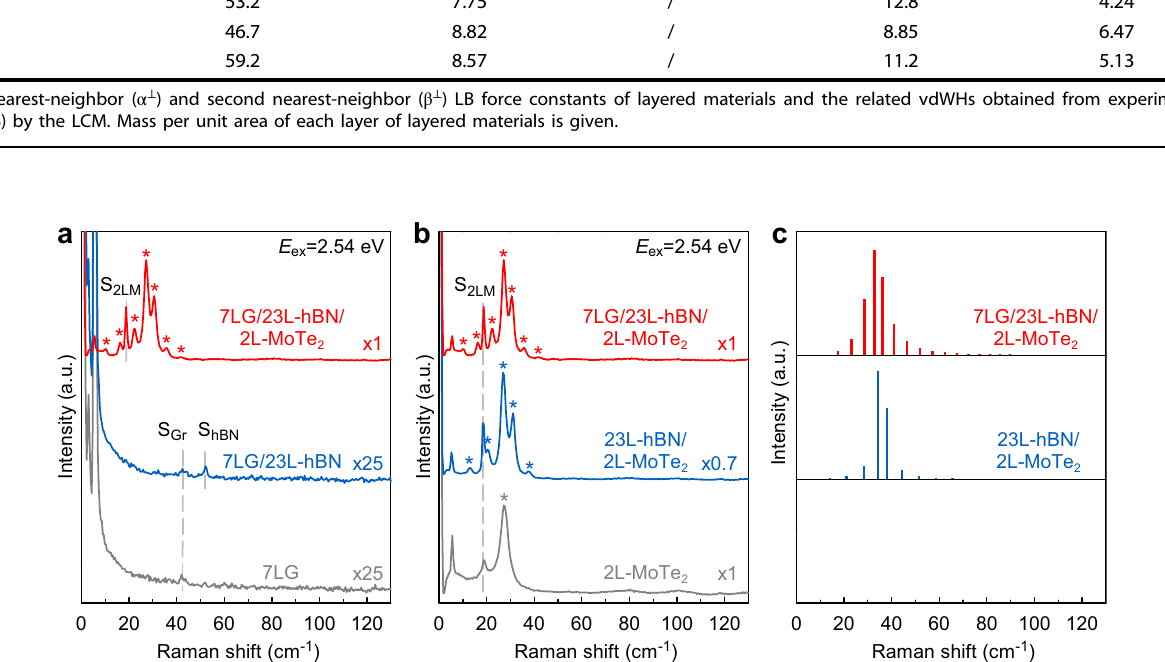
Fig. 4 Evolution of interlayer modes from individual constituents to Gr/hBN/MoTe 2 vdWH. a LF Raman spectra of 7LG, 7LG/23L-hBN, and 7LG/23L-hBN/2L-MoTe 2 . b Raman spectra of 2L-MoTe 2 , 23L-hBN/2L-MoTe 2 , and 7LG/23L-hBN/2L-MoTe 2 . c The calculated intensities of the LB modes in 23L-hBN/2L-MoTe 2 and 7LG/23L-hBN/2L-MoTe 2 based on the phonon wave function projection method 19 . The dashed lines and stars indicate Pos(S) and Pos(LB), respectively.